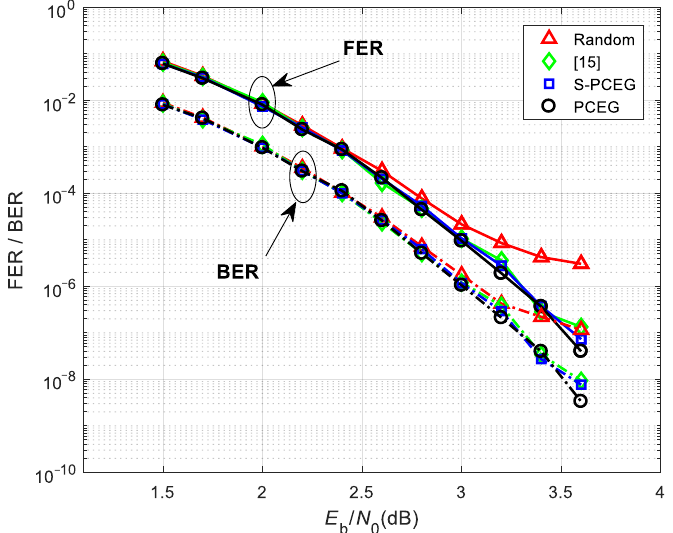
Figure 8. Performance of (2,4)-regular NB-LDPC codes over GF (64) with the code length of 312